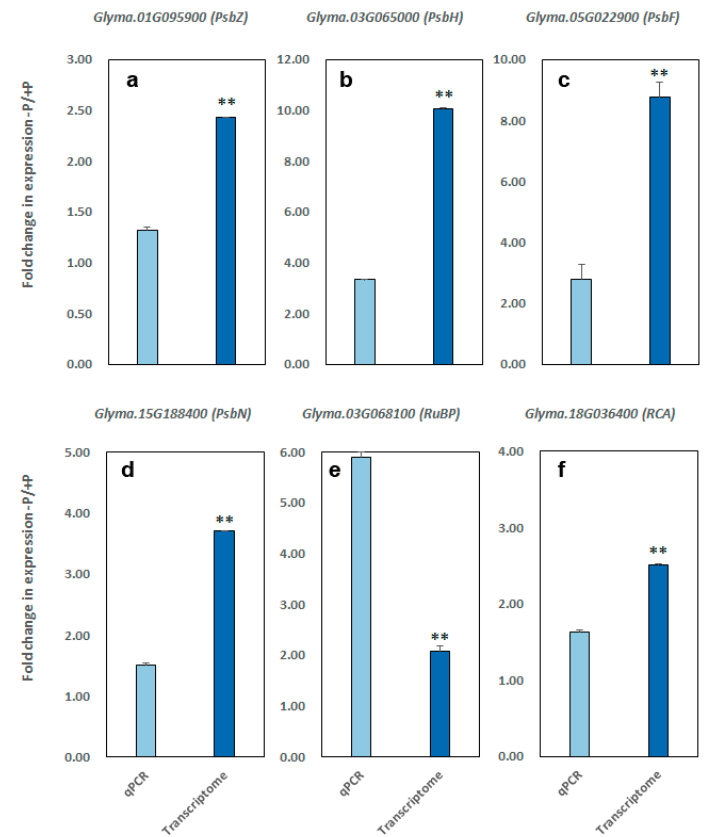
Figure 3. Relative transcript levels by transcriptome and q PCR of photosynthetic related genes under low-P condition ( − P, 5 μ mol KH 2 PO 4 ) and control (optimum P, 1000 μ mol KH 2 PO 4 ). ( a – d ) Glyma.01G095900, Glyma.03G065000 , Glyma.05G022900 , and Glyma.15G188400 encode photosystem II PsbZ protein, photosystem II PsbH protein, photosystem I subunit III PsaF protein, and photosystem